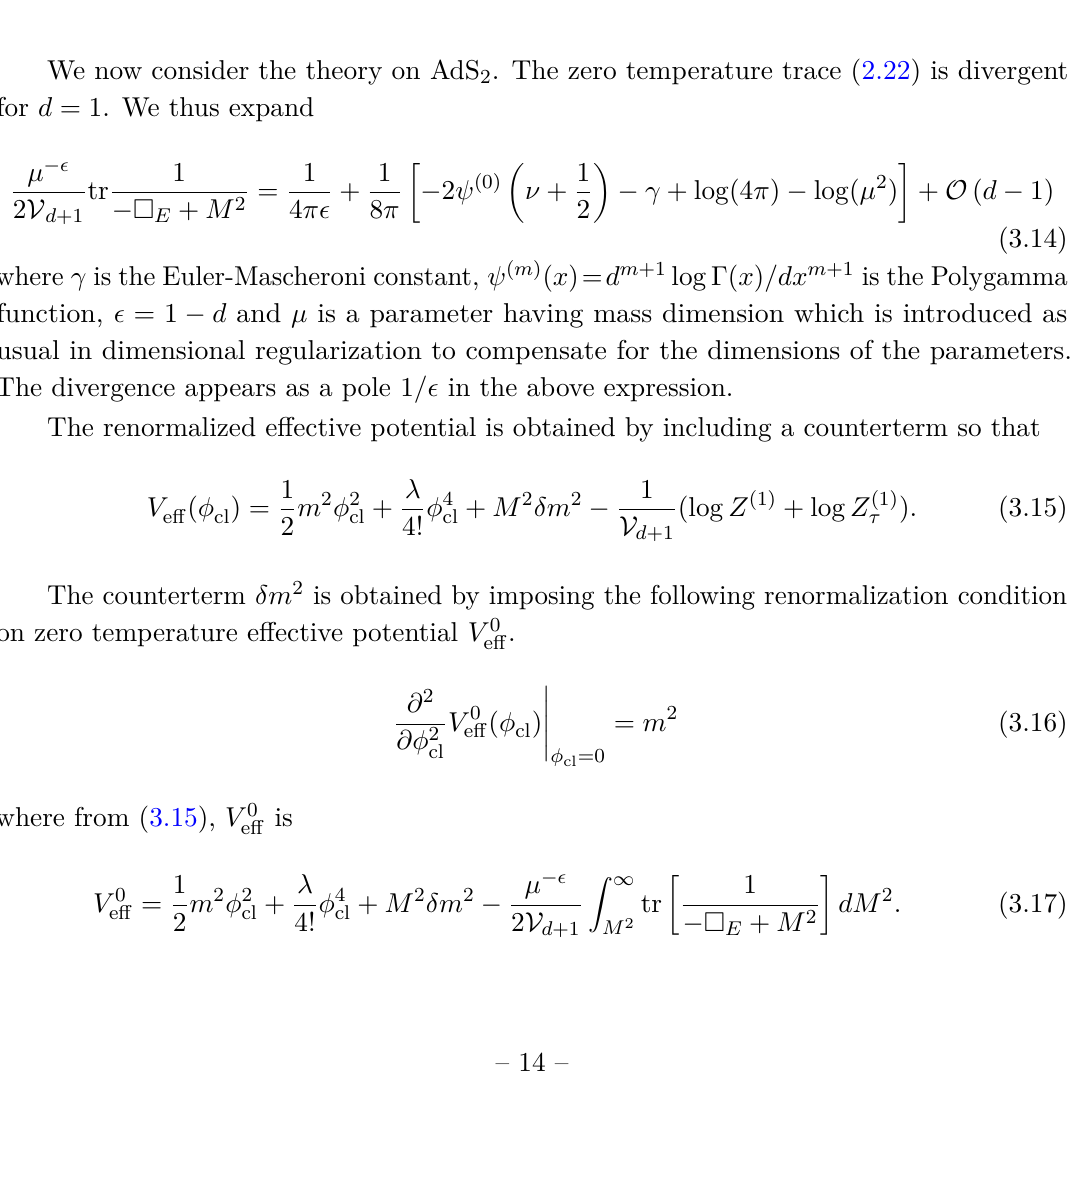
Figure 1. Phases and potentials for λ = 0 . 1